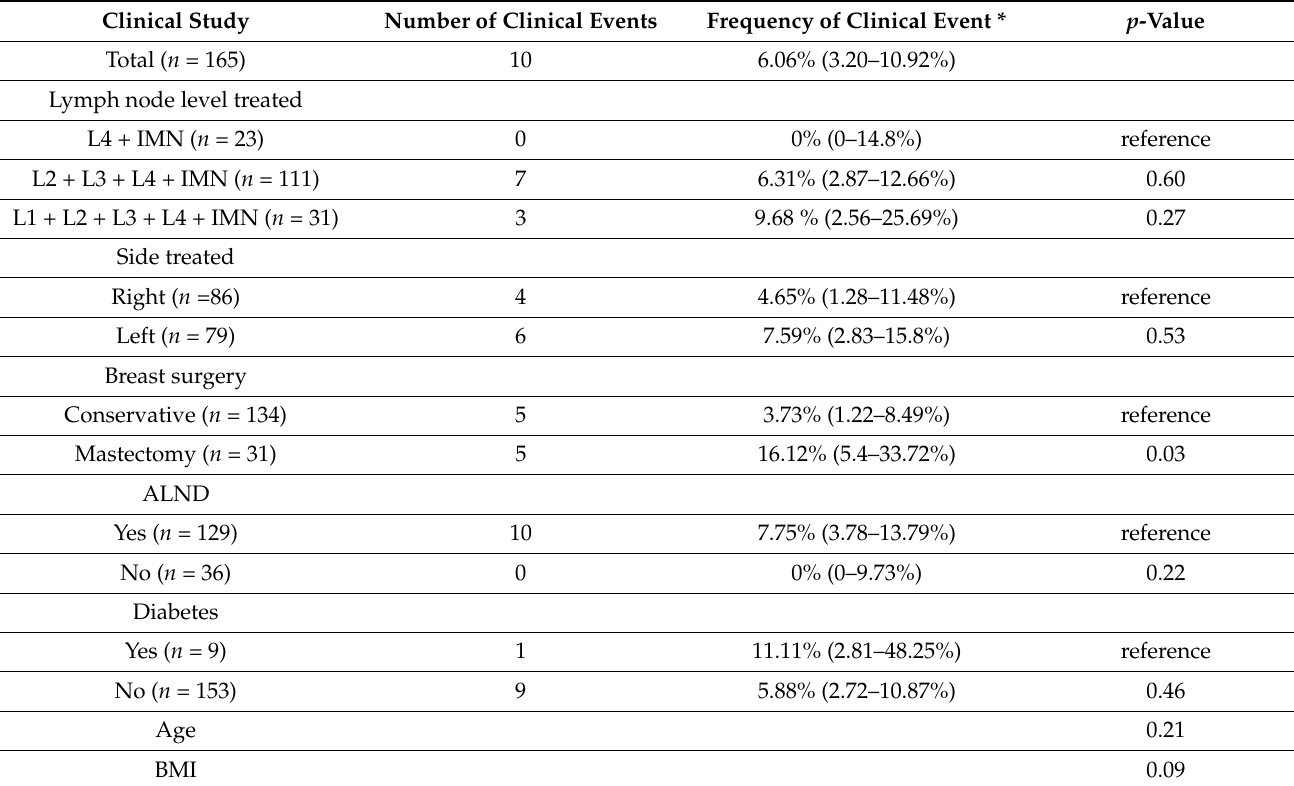
Table 3. Factors significantly associated with the occurrence of aclinical event. Gy: gray; n : number of breasts; IMN: internal mammary nodes; ALND: axillary lymph node